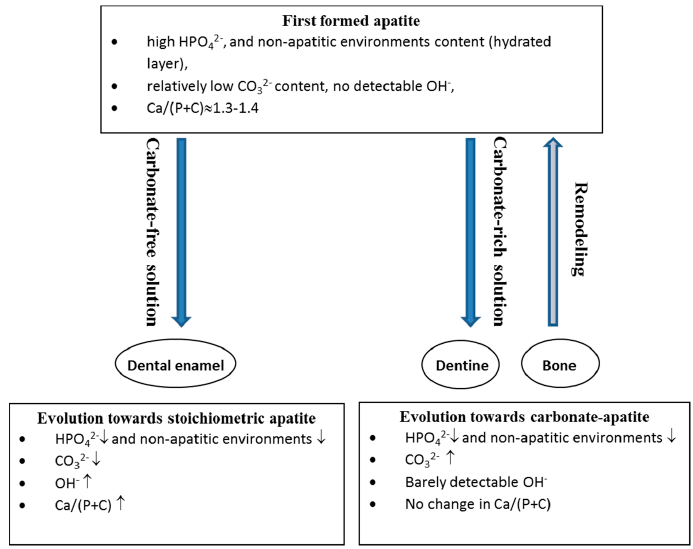
Figure 2. Maturation pathways of nanocrystalline apatites depending on the composition of the medium (the arrows, after the ions, represent an increase (or decrease) of the species considered during maturation).